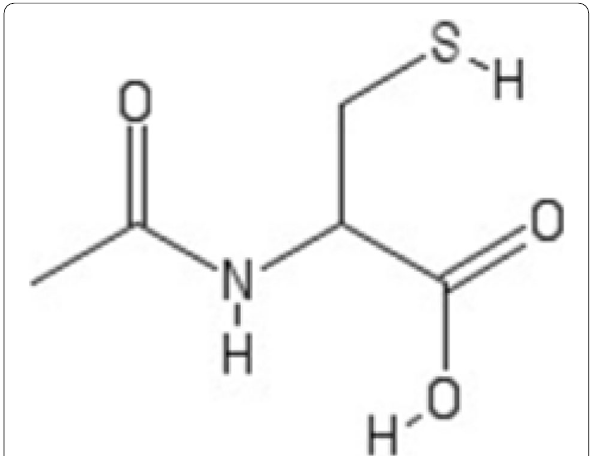
Fig. 1 Structure of the N‑acetyl cysteine